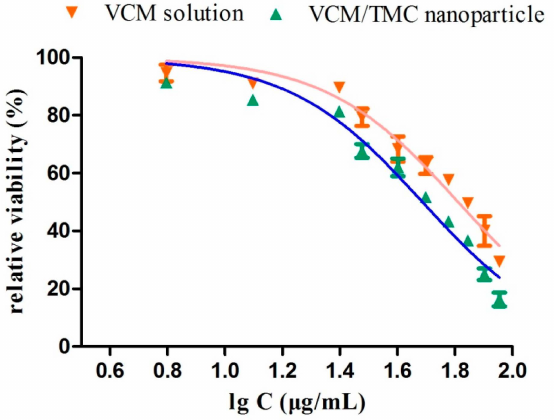
Figure 12. IC50 test of various concentrations of VCM/TMC nanoparticles and VCM solution against S. aureus .